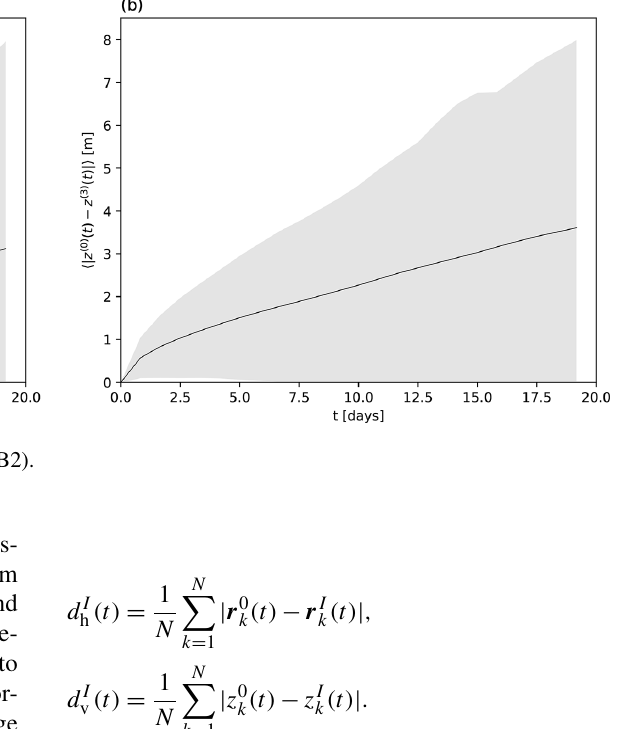
Figure B1. Solid line indicates the average horizontal distance d I same initial location but integrated with Eqs. (1) and (B1) in the NEMO velocity field. Shaded region indicates the range of the distances among the individual pairs of particles.